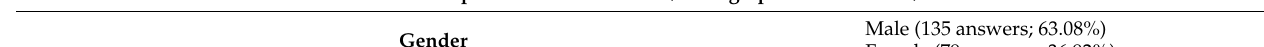
Table A2. Descriptive statistics. Sample Size and Structure (Demographic